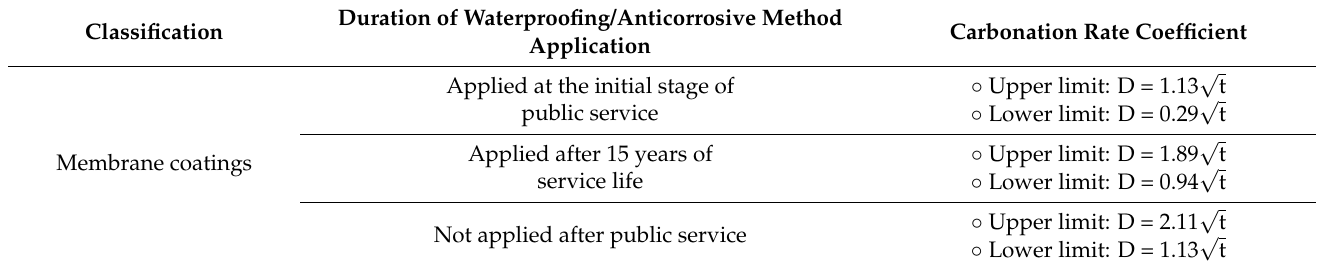
Table 8. Carbonation rate coefficients according to the duration of waterproofing/anticorrosive method